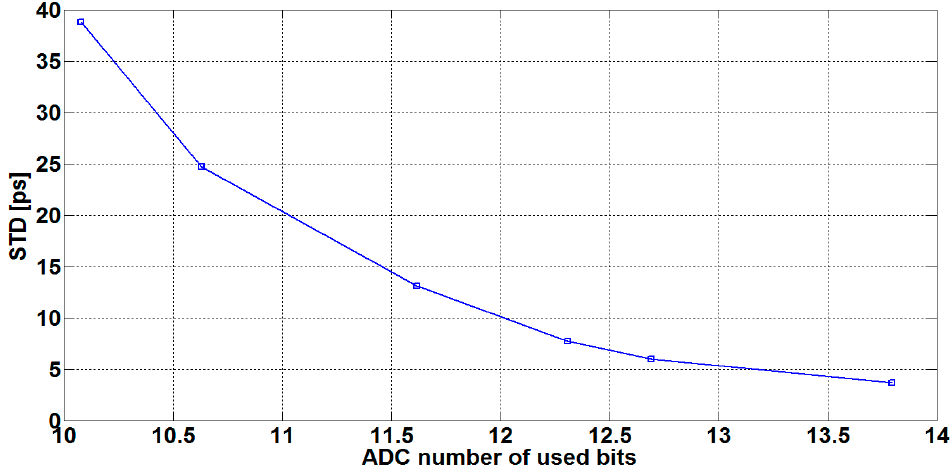
Figure 7. Transit time difference (TTD) standard deviation versus number of ADC bits (N = 250).